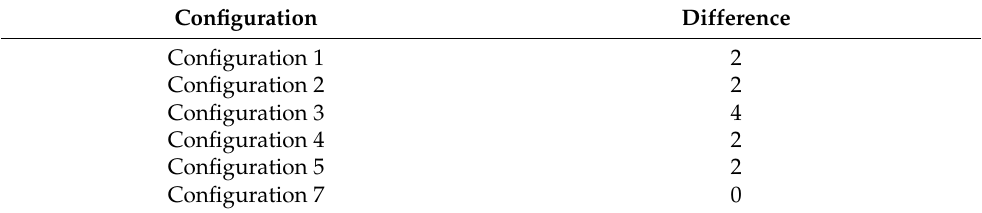
Table 7. Reduction of configurations. Configuration Difference